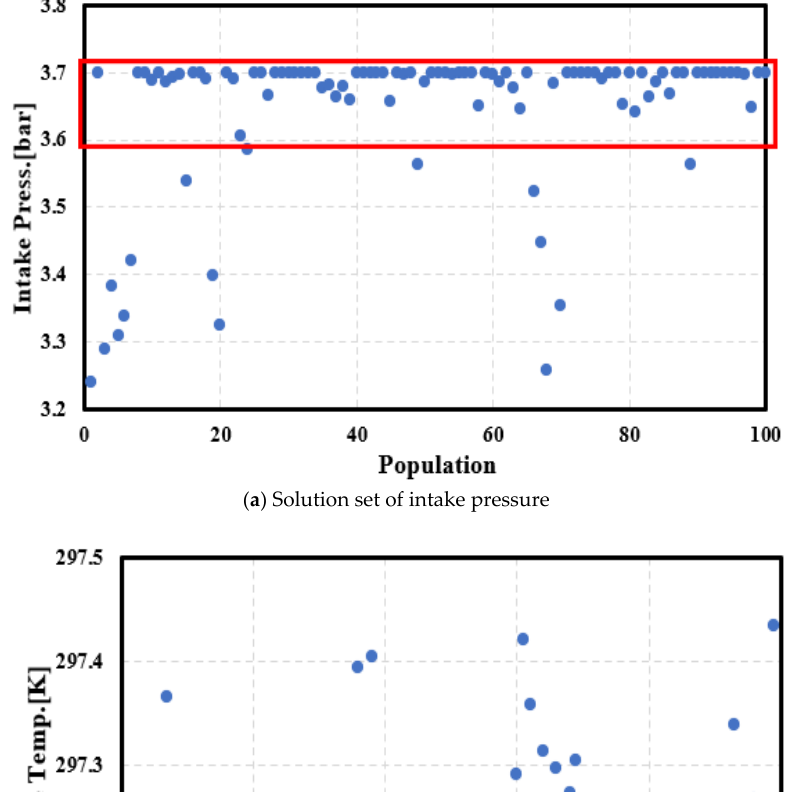
Figure 8. Overall distribution of goals.